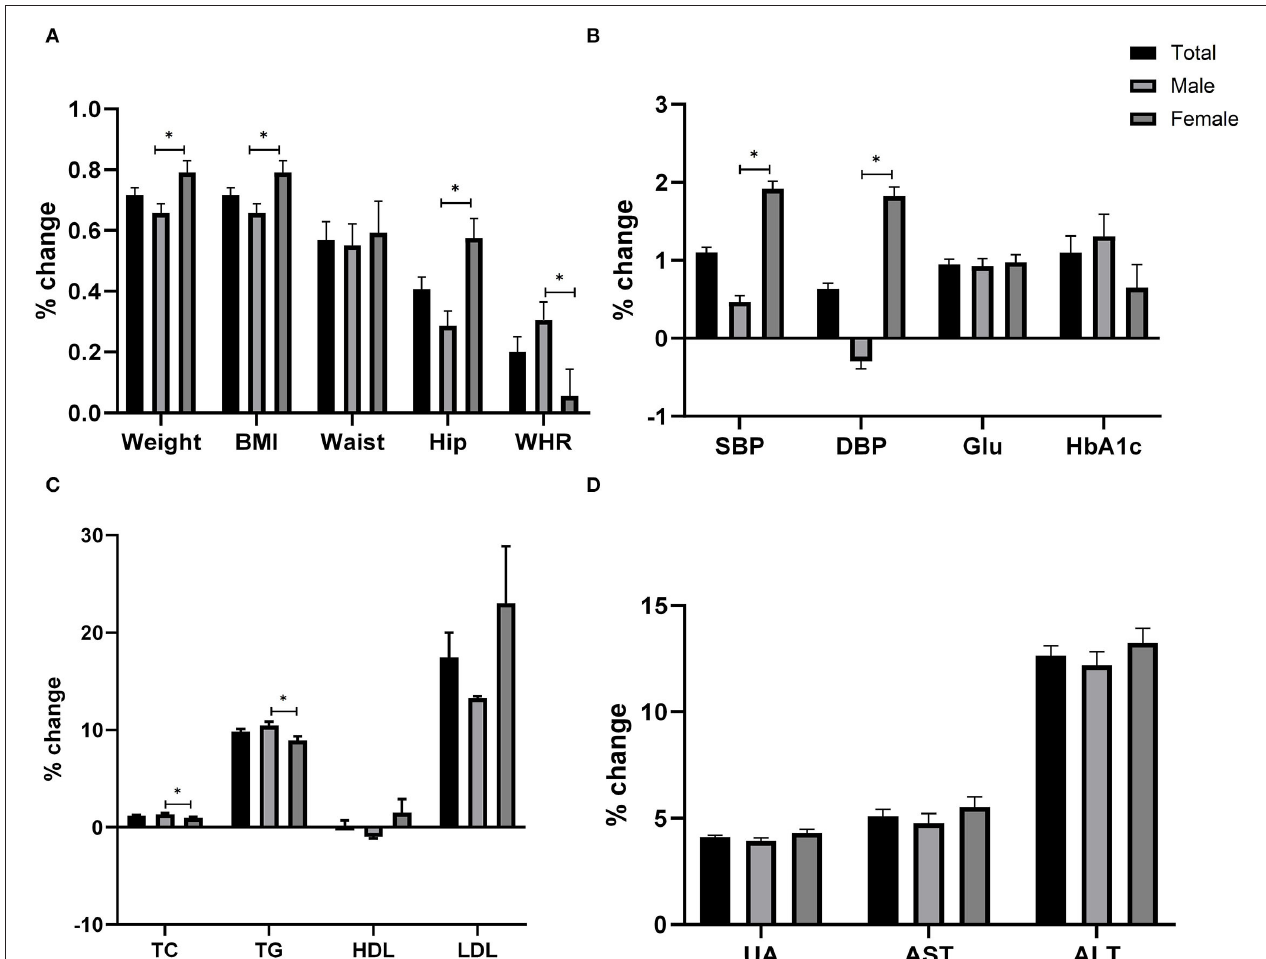
FIGURE 2 | Covid-19 pandemic exposure on cardiometabolic indexes according to sex